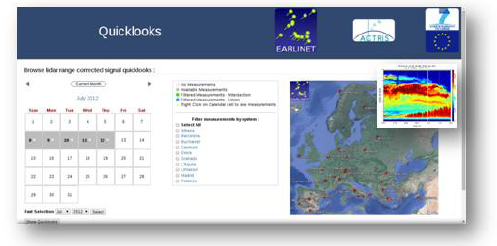
Figure 2 Web interface of the new EARLINET quicklook